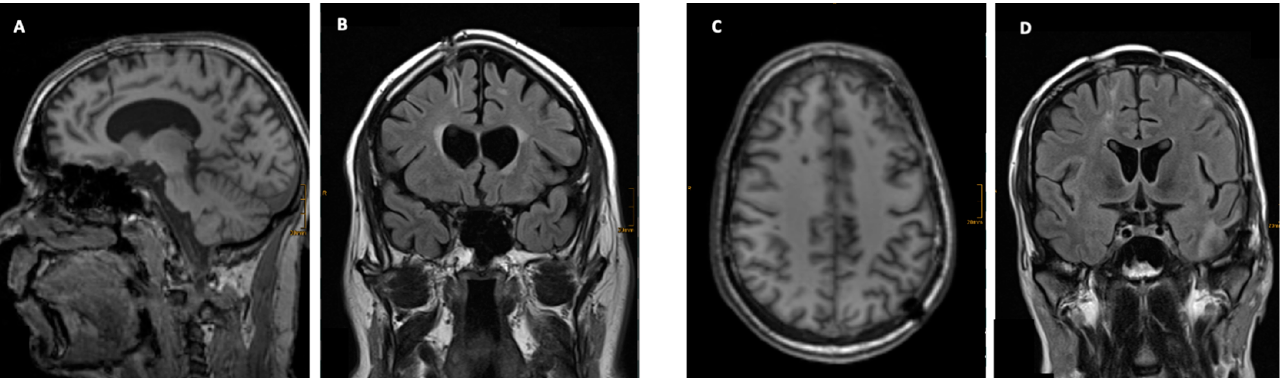
Figure 1. Examples of two patients without a lesion, but with a visible trajectory after probe removal. Panel ( A , C ) present T1-weighted MRI with corresponding coronal imaging (Panel ( B , D )).